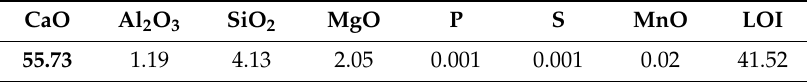
Table 2. Chemical compositions of limestone(wt %).